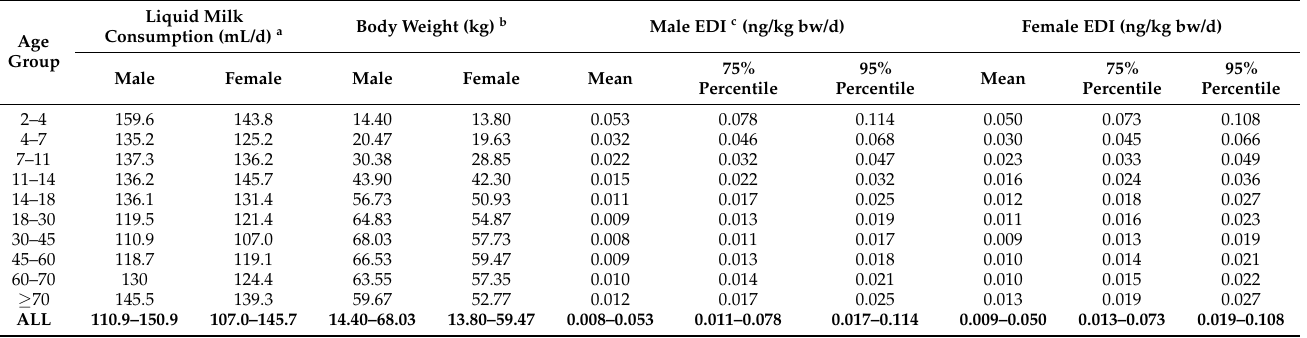
Table 2. Risk assessment of AFM1 exposure in different age-sex groups of milk